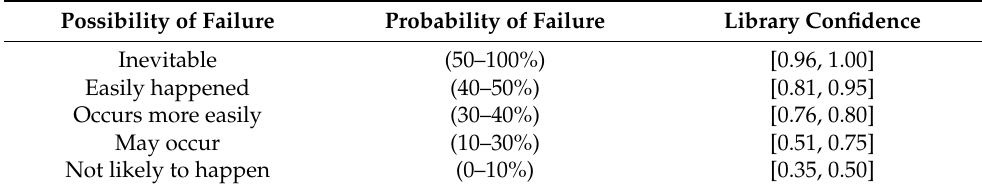
Table 1. The fuzzy definition of place value.